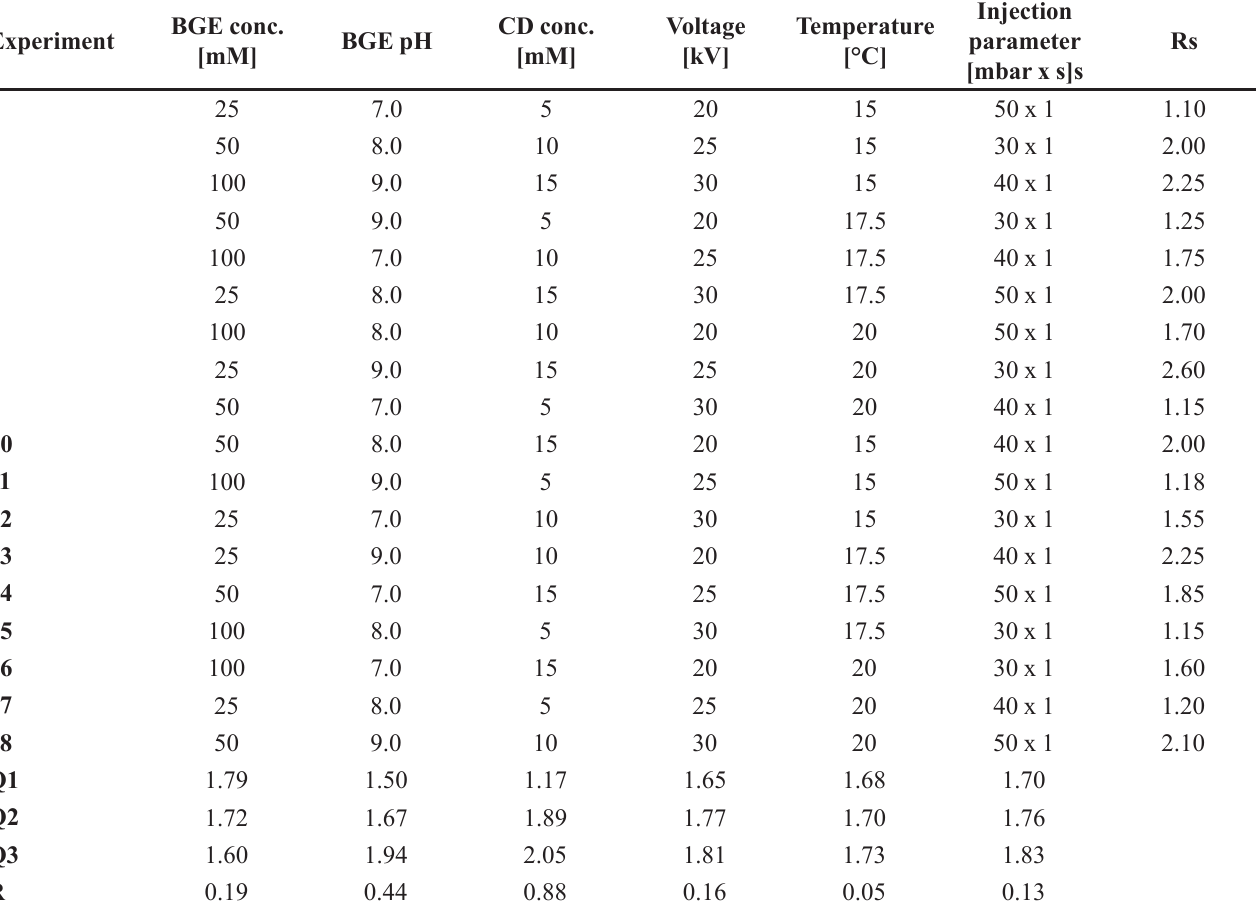
TABLE I - Orthogonal experimental design table for the AML chiral method optimization with corresponding resolution values BGE Experiment